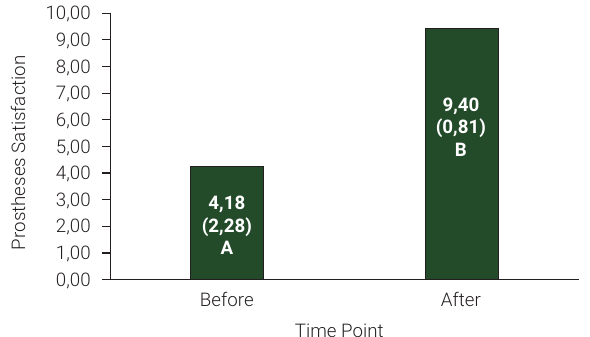
Figure 2. Mean values (SD) of patient satisfaction with the prosthetic treatment.